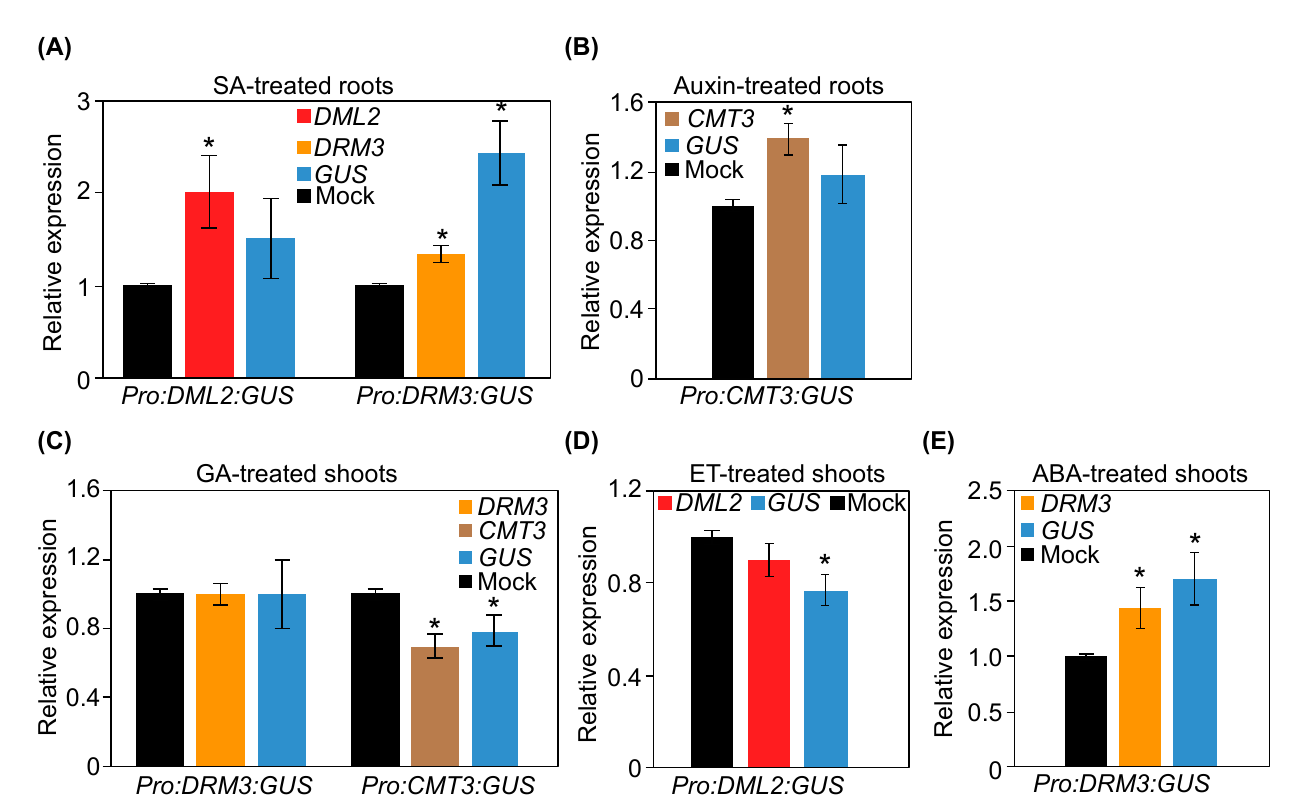
Figure 8. RT-qPCR quantification of GUS , DML2 , DRM3 , and CMT3 in the transgenic GUS reporter lines Pro:DML2:GUS , Pro:DRM3:GUS , and Pro:CMT3:GUS in response to various phytohormone treatments. ( A ): Expression levels of GUS , DML2 , and DRM3 in the roots of two-week-old Pro:DML2:GUS or Pro:DRM3:GUS plants after SA treatment. ( B ): Expression levels of GUS and CMT3 in the roots of two-week-old Pro:CMT3:GUS plants after auxin treatment. ( C ): Expression levels of GUS , DRM3 , and CMT3 in the shoots of two-week-old Pro:DRM3:GUS or Pro:CMT3:GUS plants after GA treatment. ( D ): Expression levels of GUS and DML2 in the shoots of two-week-old Pro:DML2:GUS plants after ET treatment. ( E ): Expression levels of GUS and DRM3 in the shoots of two-week-old Pro:DRM3:GUS plants after ABA treatment. Relative fold change values were calculated from three biological samples and represent expression in roots or shoots of hormone-treated transgenic plants relative to the corresponding tissues of mock-treated transgenic plants. Actin8 and PP2AA3 were used as internal controls to normalize gene expression values. Average CT (cycle threshold) values of Actin8 and PP2AA3 were used to calculated ∆∆ CT values and gene expression levels. Asterisks indicate statistically significant differences between hormone-treated and mock-treated plants at p < 0.05 according to t -test.